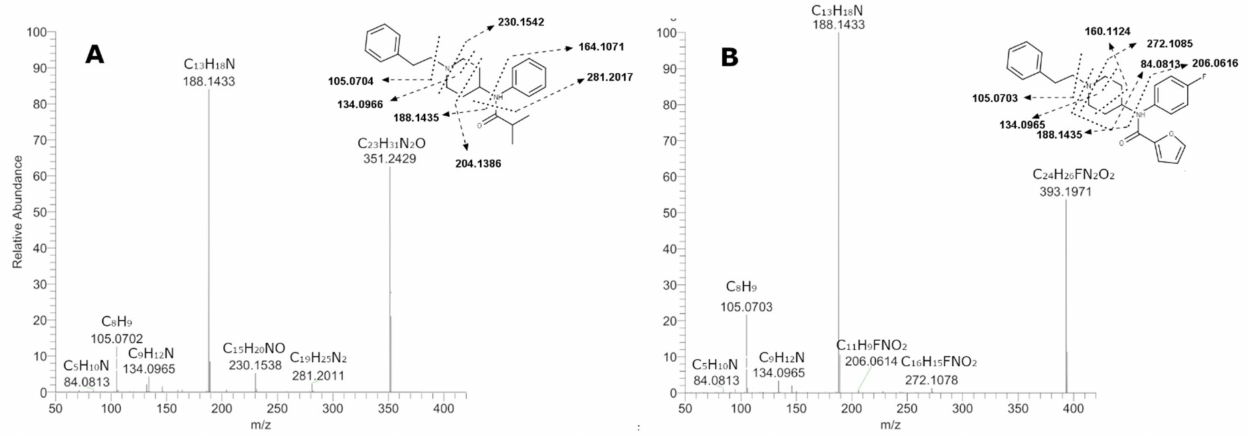
Figure 3. MS/MS fragmentation spectra of isobutyrylfentanyl ( A ) 4-fluoro-furanylfentanyl ( B ) and the postulated fragmen- tation